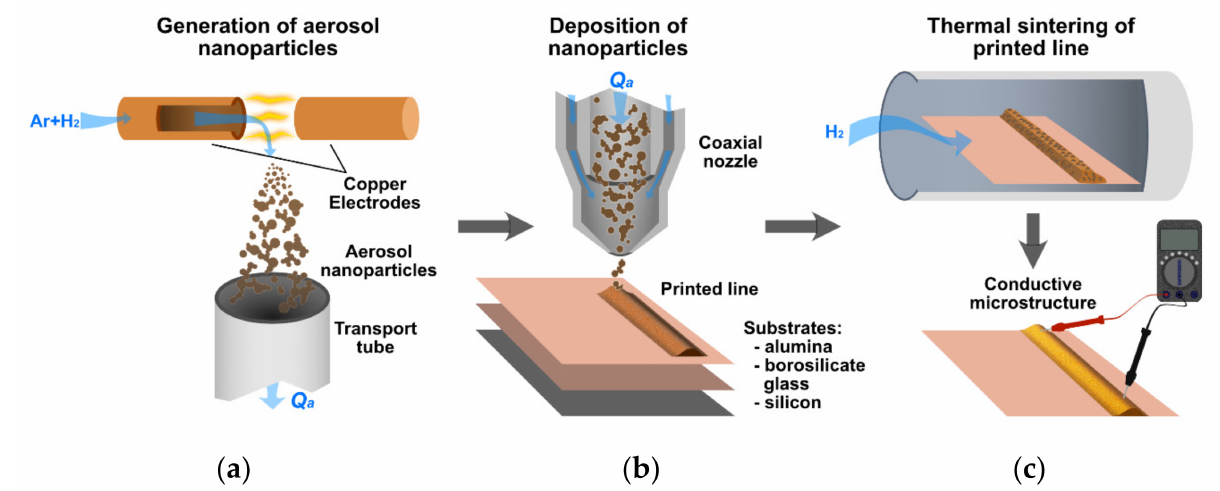
Figure 1. Scheme of the formation of printed lines from nanoparticles on various substrates, including ( a ) generation, ( b ) focused deposition, and ( c ) thermal sintering